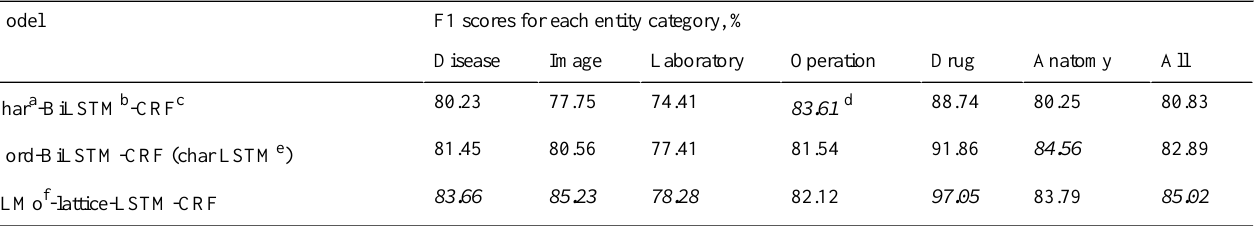
Table 8. Comparison of the results regarding each entity category when using the China Conference on Knowledge Graph and Semantic Computing (CCKS)-2019 clinical named entity recognition (CNER)